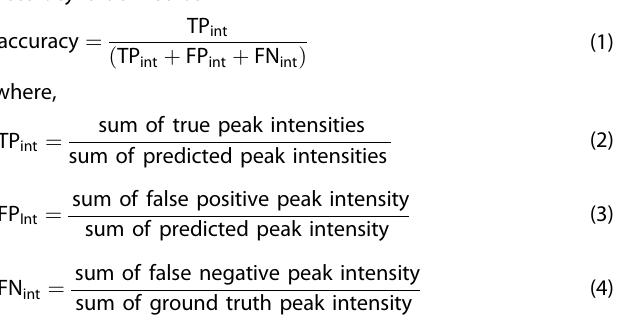
weighted accuracy of the disk locations determined by each method, using the simulated test dataset with different crystal orientations and in-plane rotations. The intensity-weighted accuracy is de fi ned as